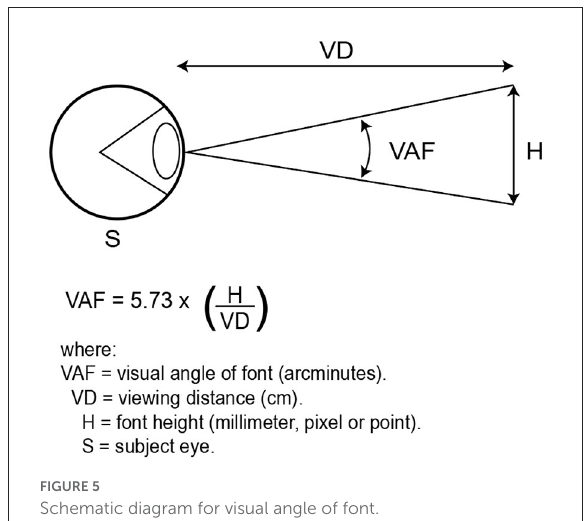
FIGURE5 Schematic diagram for visual angle of